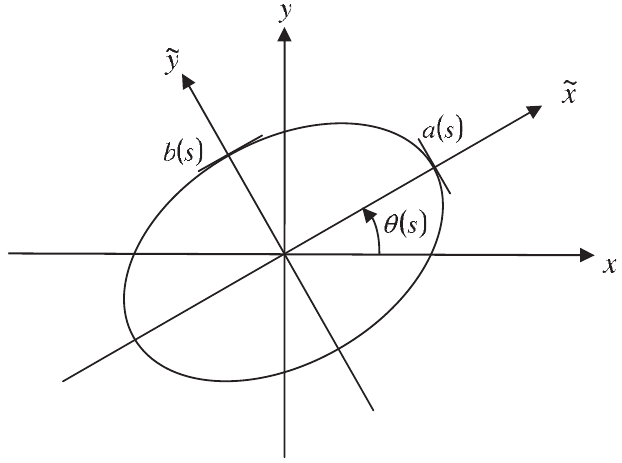
FIG. 1. Laboratory and twisted coordinate applied magnetic field with S (cid:6) 2 (cid:2)=k (cid:3) x; y; s (cid:4) (cid:6) const is the number of particles 2 (cid:2) R 1 dxdyn b